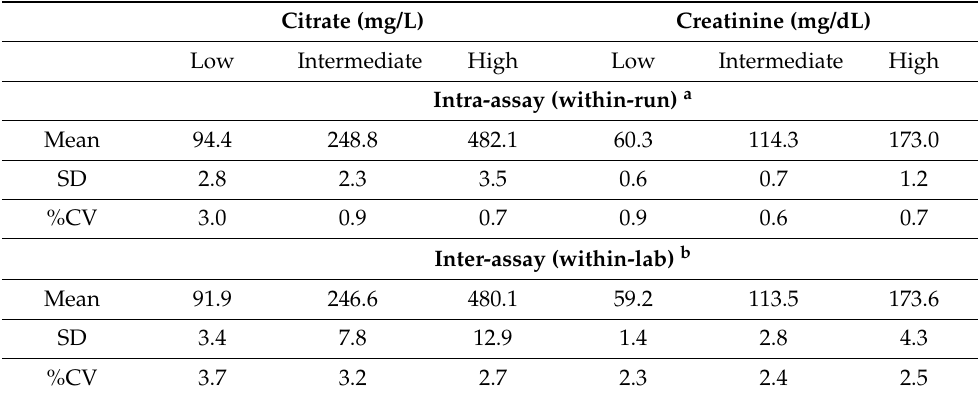
Table 1. Intra- and Inter-assay imprecision for citrate and creatinine measured in urine. Citrate (mg/L) Creatinine (mg/dL) Low Intermediate High Low Intermediate High Intra-assay (within-run) a Mean 94.4 248.8 482.1 60.3 114.3 173.0 SD